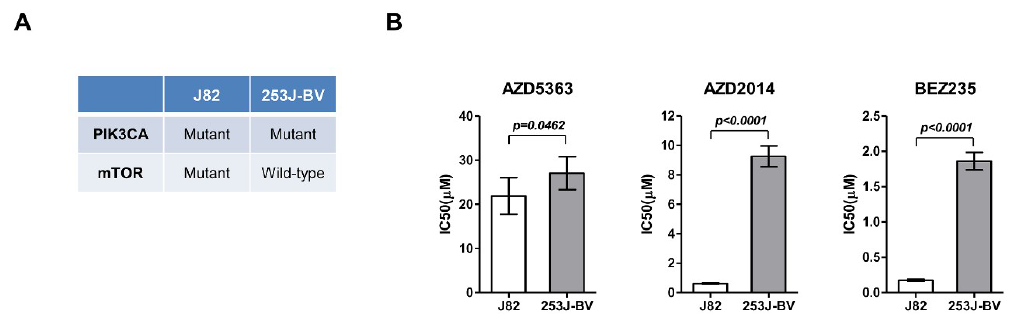
Figure 2. E ff ects of an AKT inhibitor (AZD5363) and mTOR inhibitors (AZD2014 and BEZ235) on the proliferation of mTOR-mutated or wild-type bladder cancer cells. ( A ) Molecular characteristics of J82 and 253J-BV cell lines. ( B ) E ff ects of AZD5363, AZD2014, and BEZ235 on J82 and 253J-BV cells were determined using CellTiter Glo. The results are presented as the mean ± SD of triplicate wells and are representative of three independent experiments.